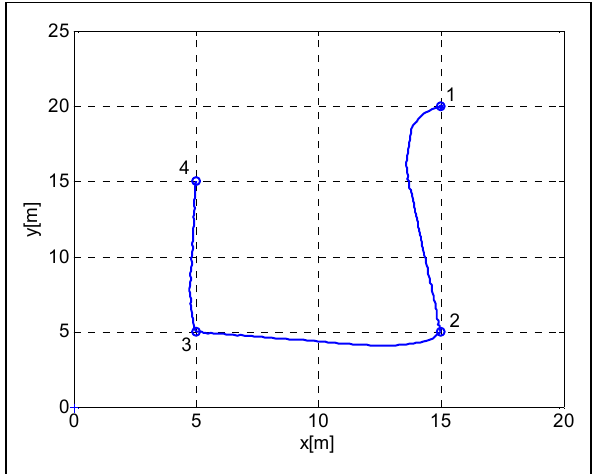
Figure 5. Robot trajectories in the way-point navigation task.